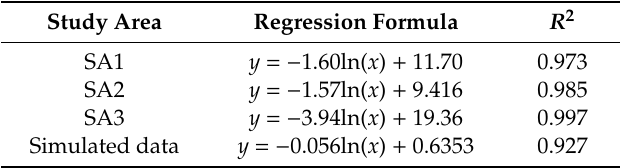
Table 9. Functional relationship between the slope RMSE ( y ) and the number of points in the neighbourhood ( x ) in study areas 1–3 and simulated data.